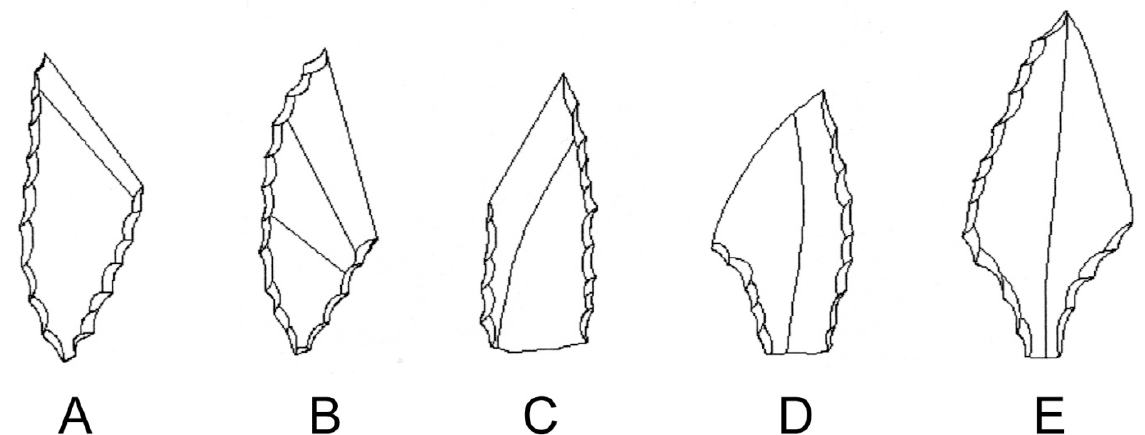
Figure 5. Sub-types of the single-edged point suggested by Møllenhus (1977) (redrawn byTorben Bjarke Ballin 2015). Today, only his Types B and D would be accepted as single-edged points.